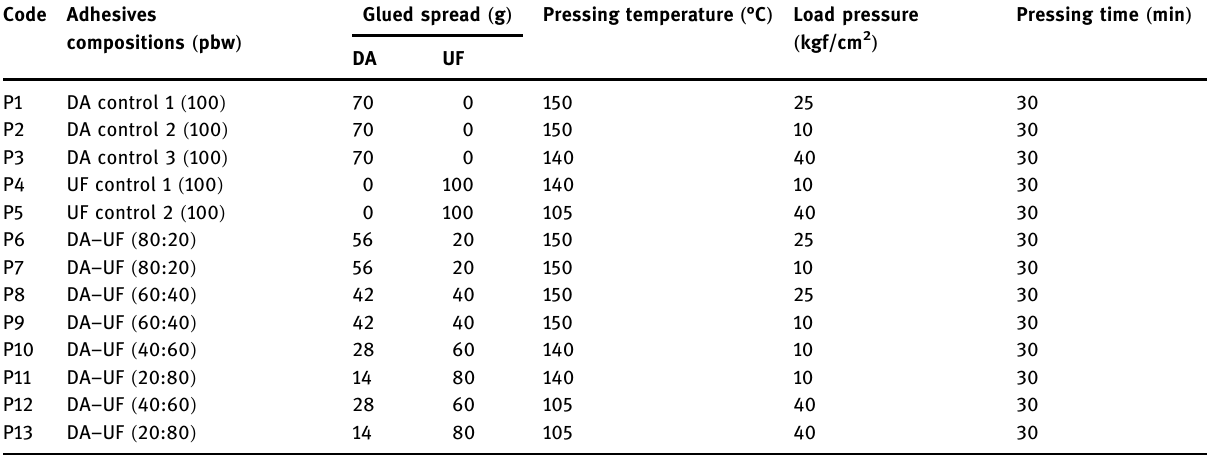
Table 1: Manufacturing parameters of particleboards Code Adhesives